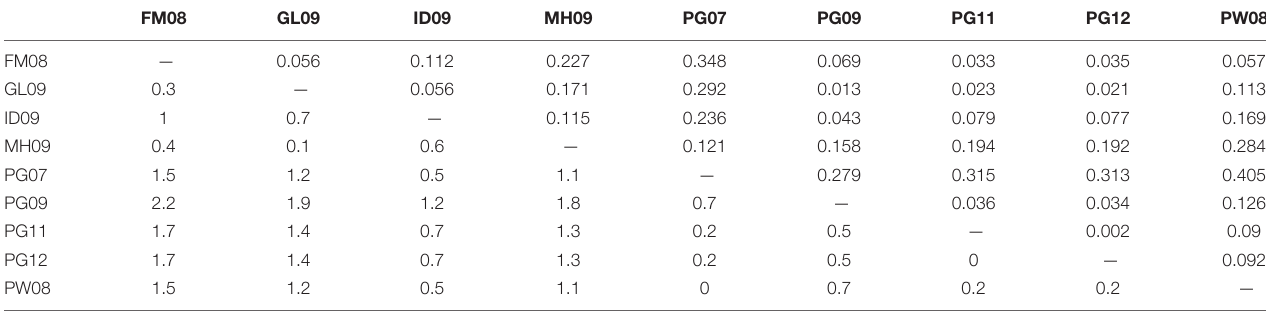
TABLE 6 | Differences in SST (below diagonal, in ◦ C) and chlorophyll-a concentrations (above diagonal, in mg/m 3 ) between sample group